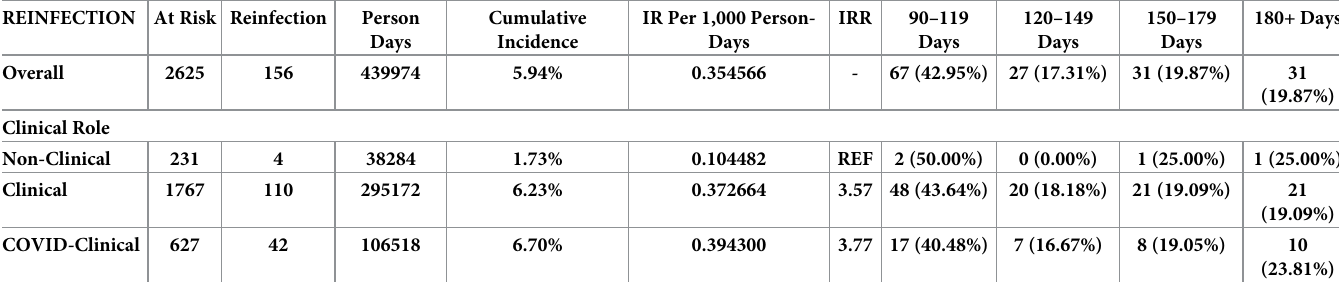
Table 1. Incidence measures representing risk of COVID-19